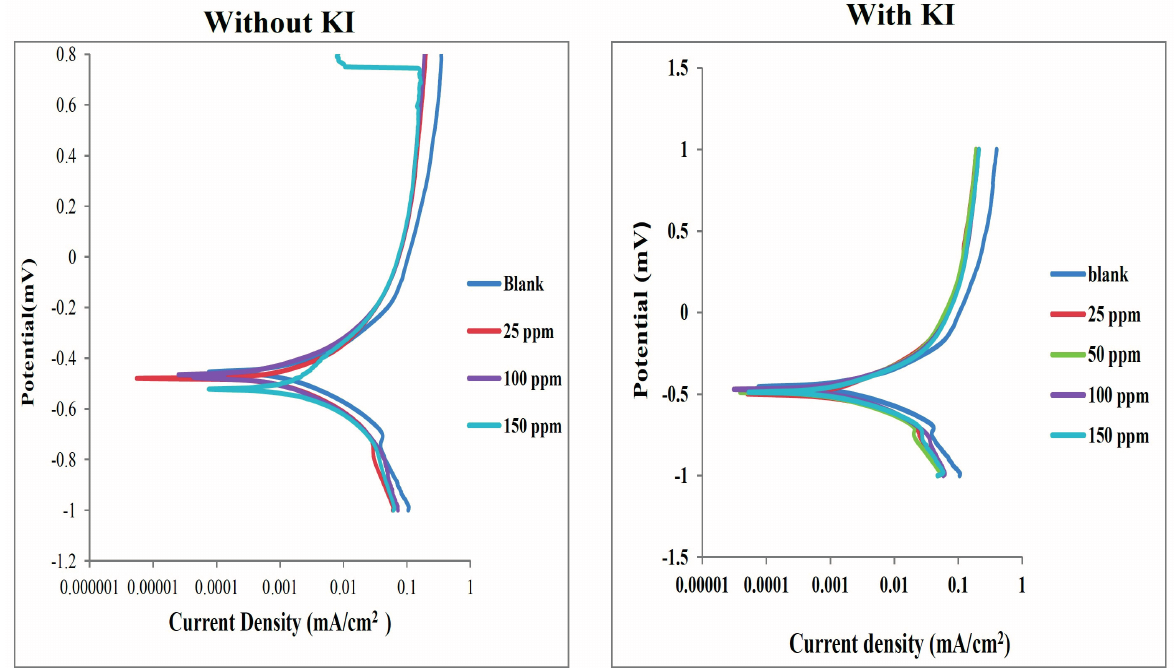
Figure 4. Potentiodynamic polarization curves for mild corrosion in 0.5 M HCl without and with various concentrations of SS without KI ( left-hand side ) and with KI ( right-hand side